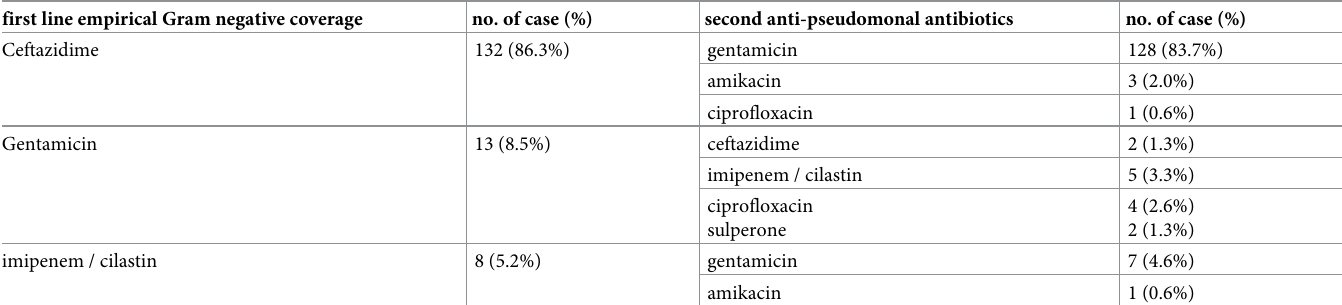
Table 2. Summary of antibiotic therapy.